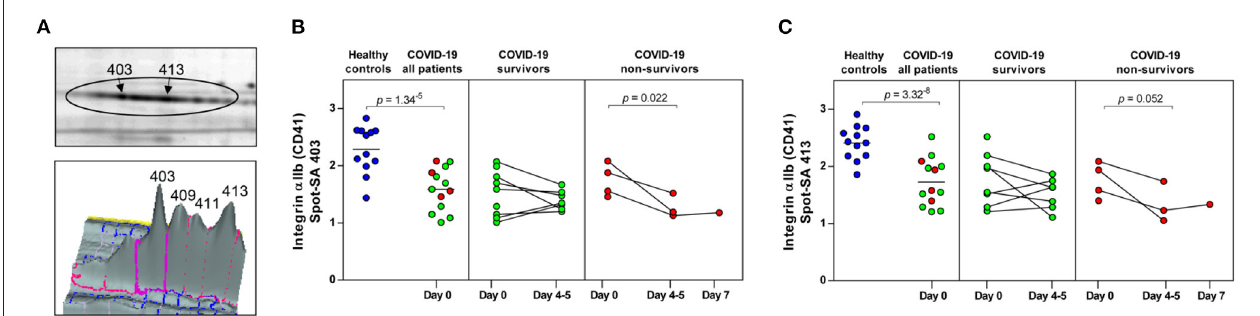
FIGURE 3 | COVID-19 and mortality-dependent course of the abundance of integrin α IIb in platelets. (A) Illustration of the 2-D profile of the integrin α IIb (ITGA2B or CD41) spot chain from the 2D-DIGE analysis. (B,C) Protein levels of the ITGA2B proteoforms (spot 403 and 413). Scatter dot plot and time course of COVID-19 patients of ITGA2B standardized abundance (SA) of the platelet protein spots quantified by 2D-DIGE (healthy controls: n = 12; COVID-19 survivors: n = 9; COVID-19 non-survivors: n = 4). Protein levels were depicted as single values and mean. 2D-DIGE, two-dimensional differential in-gel electrophoresis.